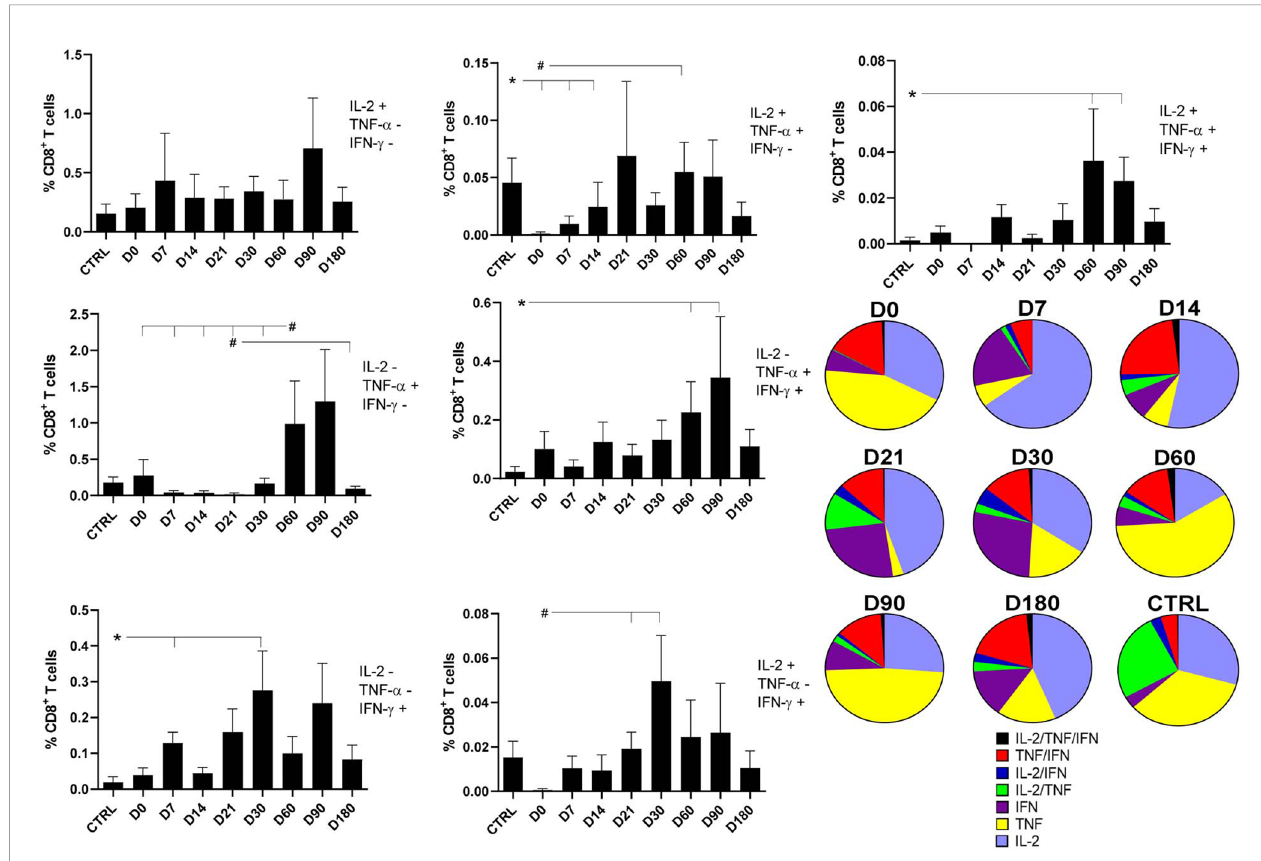
FIGURE 4 | Distinct quality of CD8 + T in follow-up of visceral leishmaniasis (VL) treatment and of endemic control subjects. Evolution of the frequencies of CD8 + T cells producing one cytokine (IL-2, TNF- a , or IFN- g ), and any combination of two or all three cytokines along the time. Each frequency was recorded after background subtraction of cells incubated without antigen [soluble Leishmania antigen (SLA)]. Results are expressed as means+SE, with asterisks and horizontal lines indicating signi fi cant differences between times of treatments and healthy controls as disclosed by the Mann – Whitney method. Hashtags show signi fi cant differences between times of treatment as determined by the Wilcoxon matched-pairs rank statistical